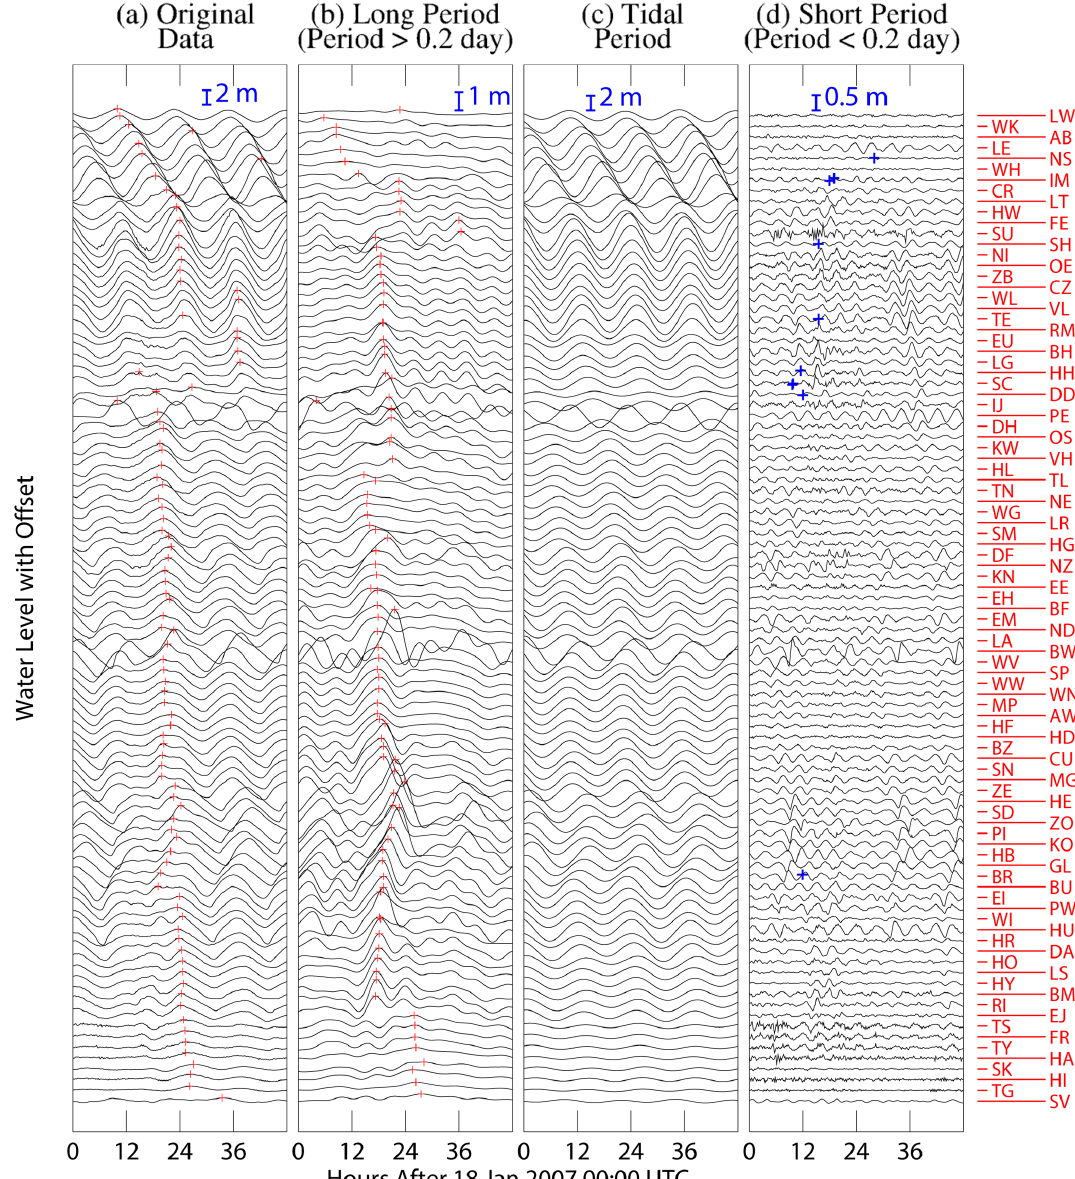
Figure 6. Time series of the (a) original water level data, and reconstructions of the (b) long period, (c) diurnal plus semi-diurnal tide, and (d) short period components of the original time series. The station identifications are given by two letter codes along the right hand side of (d) . The stations have been vertically offset according to their relative arrangement counter-clockwise around the North Sea, starting from Lerwick in Scotland at the top and ending with Stavanger in Norway at the bottom. Blue vertical crosses mark the time of maritime incidents at the closest tide gauge station. Red vertical crosses indicate the maximum of the data segment